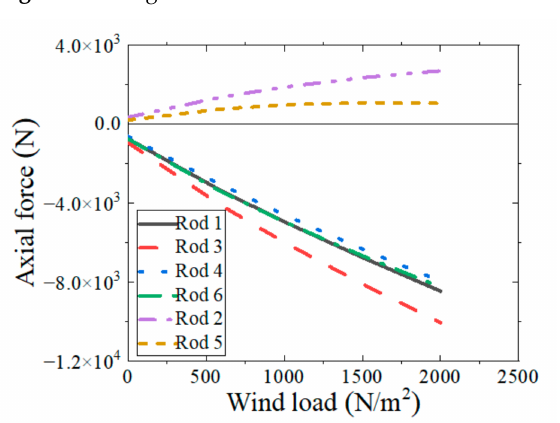
Figure 7. Triangle brackets.